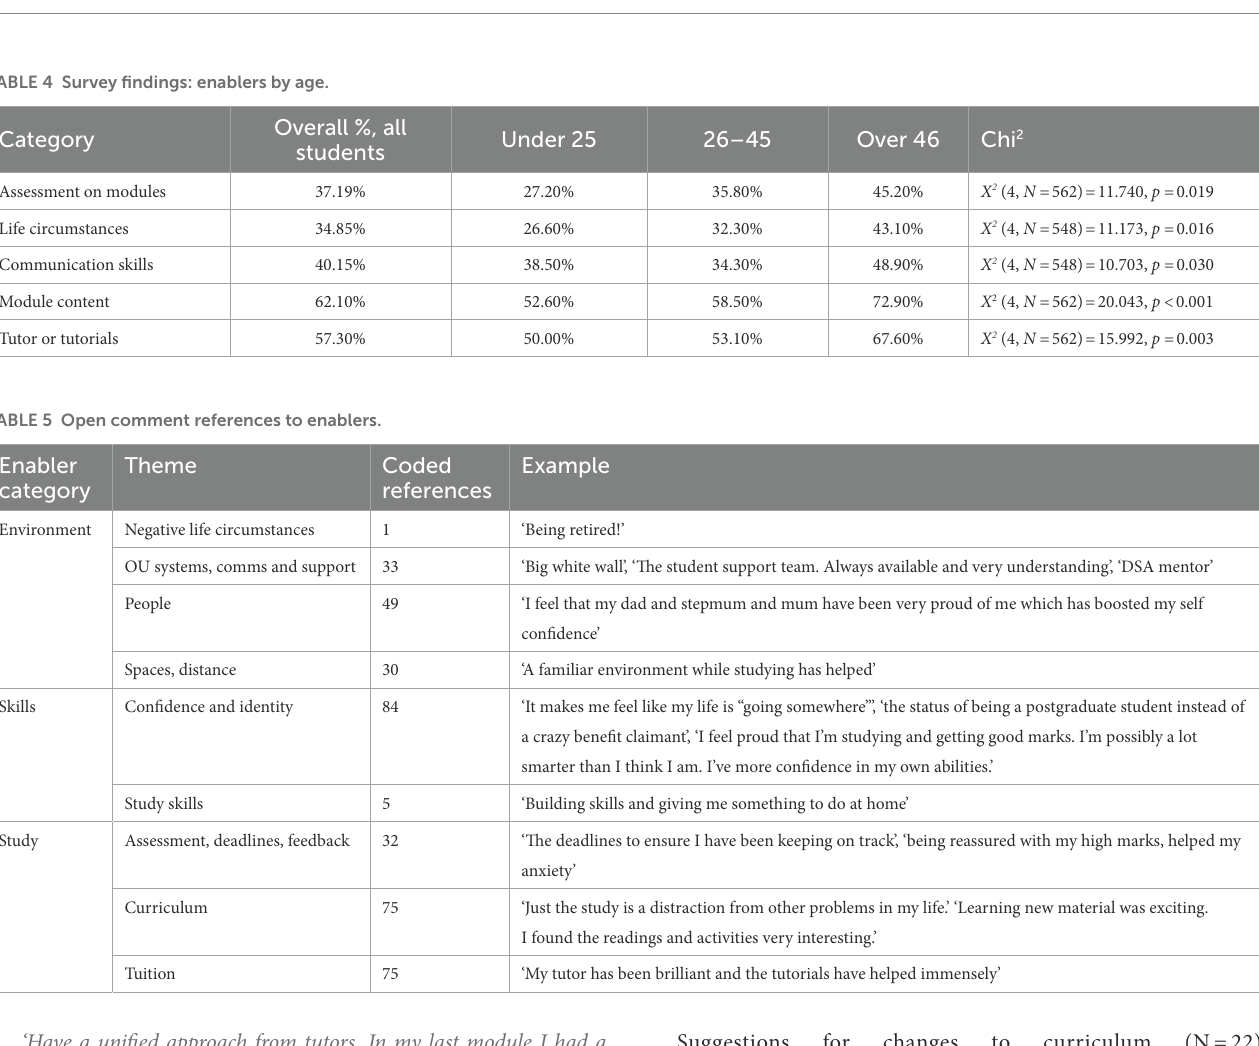
FIGURE 4 Impact of study on wellbeing.